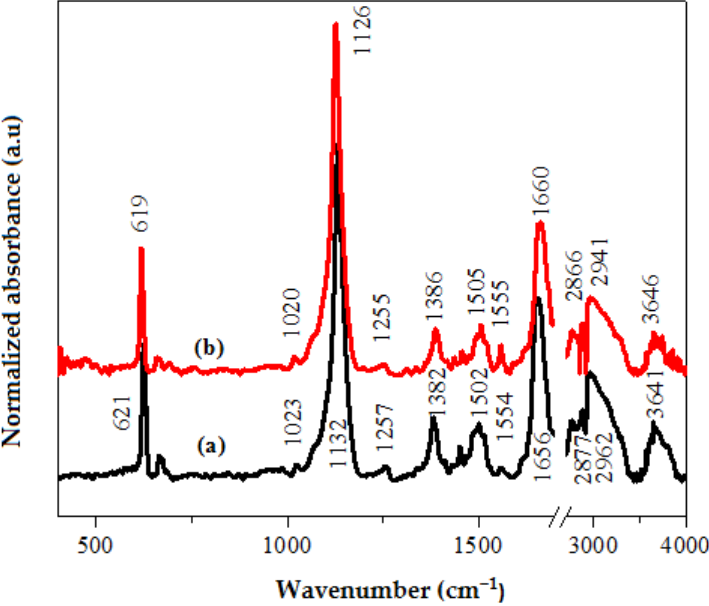
Figure 1. FTIR spectrum of pure ( a ) and acid-doped ( b ) PANI. The spectra of Figure 1 have been normalized by referring to the band situated at 1132 (1126) cm − 1 , attributed to the benzene ring deformation. Spectra show that the same bands are found after doping but the band intensity and positions are changed (Table 1), demonstrating that the material skeleton is conserved. The intensity increase/decrease and the slight frequency shift are the consequences of the geometrical relaxation after